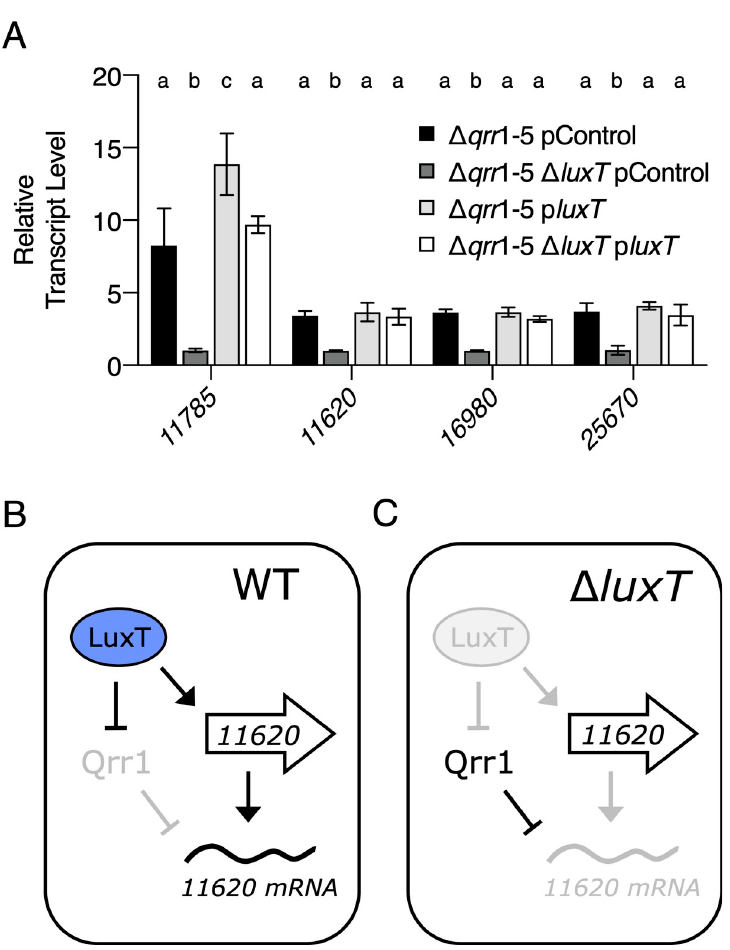
Fig 4. LuxT activates target genes by two regulatory mechanisms. (A) qRT-PCR of the indicated VIBHAR_RS genes in the designated V . harveyi strains. The pControl plasmid is the empty parent vector and the plasmid designated p luxT carries luxT under the IPTG-inducible tac promoter. In all cases, 0.5 mM IPTG was added and samples were collected at OD 600 = 1. Error bars represent standard deviations of the means of n = 3 biological replicates. Different letters indicate significant differences between strains, p < 0.05 (two-way analysis of variation (ANOVA) followed by Tukey’s multiple comparisons test). (B) Working model for how LuxT activates a target gene, with VIBHAR_RS11620 as the example in WT V . harveyi . (C) As in B for Δ luxT V . harveyi . https://doi.org/10.1371/journal.pgen.1009336.g004 reporters are all activated by aTc and repressed following overexpression of qrr 1 in V . harveyi (S11 Fig). The translational mVenus reporter fusions were used to test the aspect of our model in which we predict that LuxT activates target genes post-transcriptionally via qrr 1 repression. Reporter activities from the four target gene constructs were measured in the following LCD- locked V . harveyi strains: luxO D61E, luxO D61E Δ luxT , luxO D61E Δ qrr 1, and luxO D61E Δ qrr 1 Δ luxT . The results for all four reporters were similar (Fig 5A–5D). The luxO D61E strain exhibited higher reporter activity than the luxO D61E Δ luxT strain, presumably due to the de- repression of qrr 1 that occurs in the absence of LuxT. Importantly, deletion of luxT in the luxO D61E Δ qrr 1 strain had no effect on reporter translation (Fig 5A–5D, compare luxO D61E Δ qrr 1 and luxO D61E Δ qrr 1 Δ luxT bars). We conclude that LuxT post-transcriptionally regulates the four tested genes in a Qrr1-dependent manner. We note that higher translation